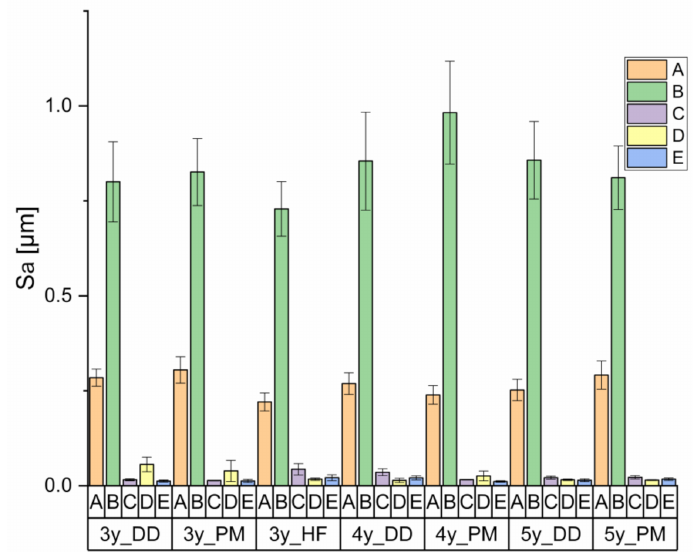
Figure 4. Comparison of Sa between the different Y-TZPs (Table 1) and treatments (Table 2: A—untreated, B—grinding, C—grinding and polishing, D—polishing and E—grinding, polishing, chewing, and thermocycling).